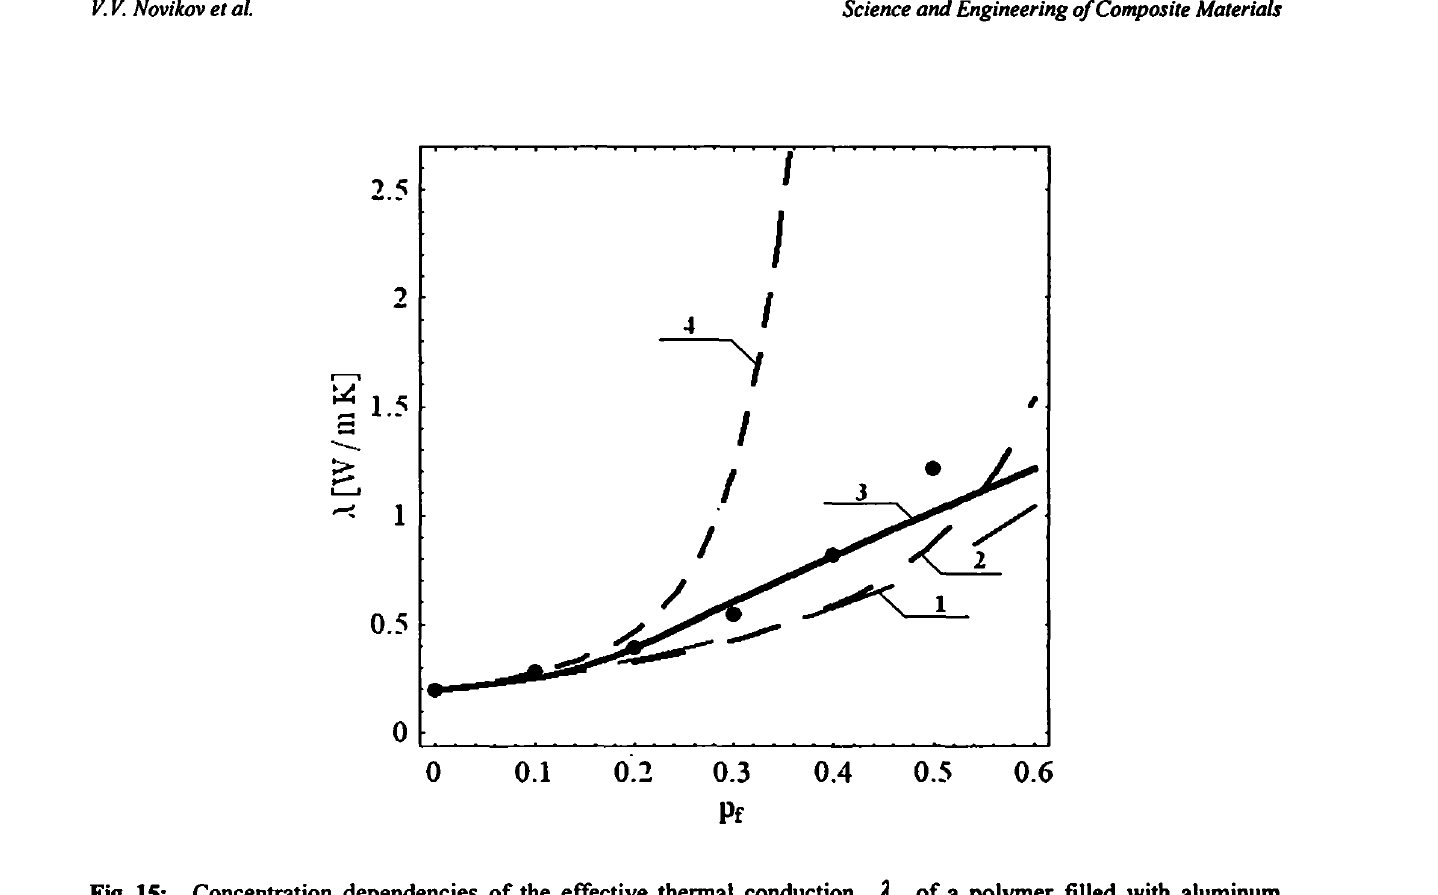
Fig. 15: Concentration dependencies of the effective thermal conduction, λ, of a polymer filled with aluminum obtained on the basis of different models: 1 - Maxwell model; 2 - Lewis - Nielsen model; 3 - iteration averaging method; 4 - model of an effective medium; · - experimental data (dots)